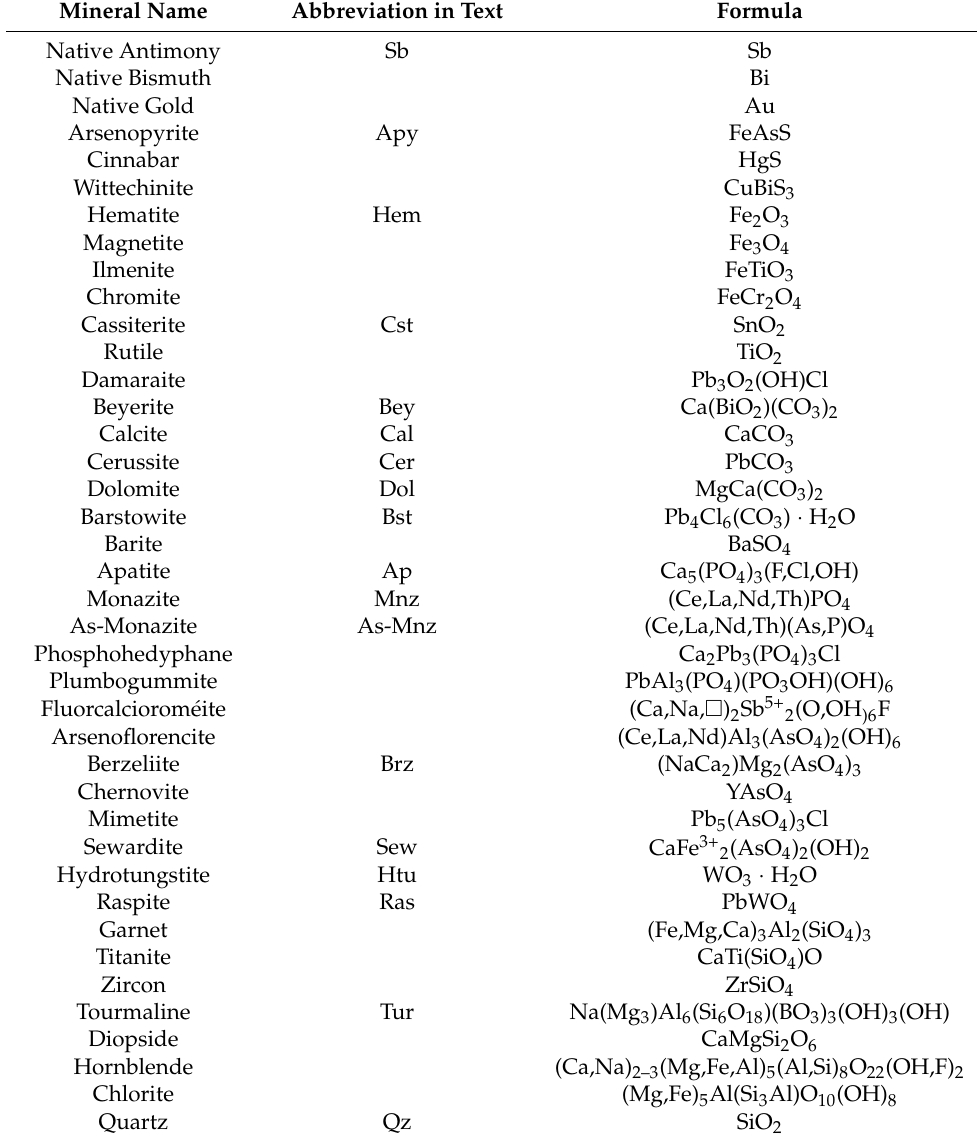
Table 1. Minerals identified in heavy mineral separate and hand